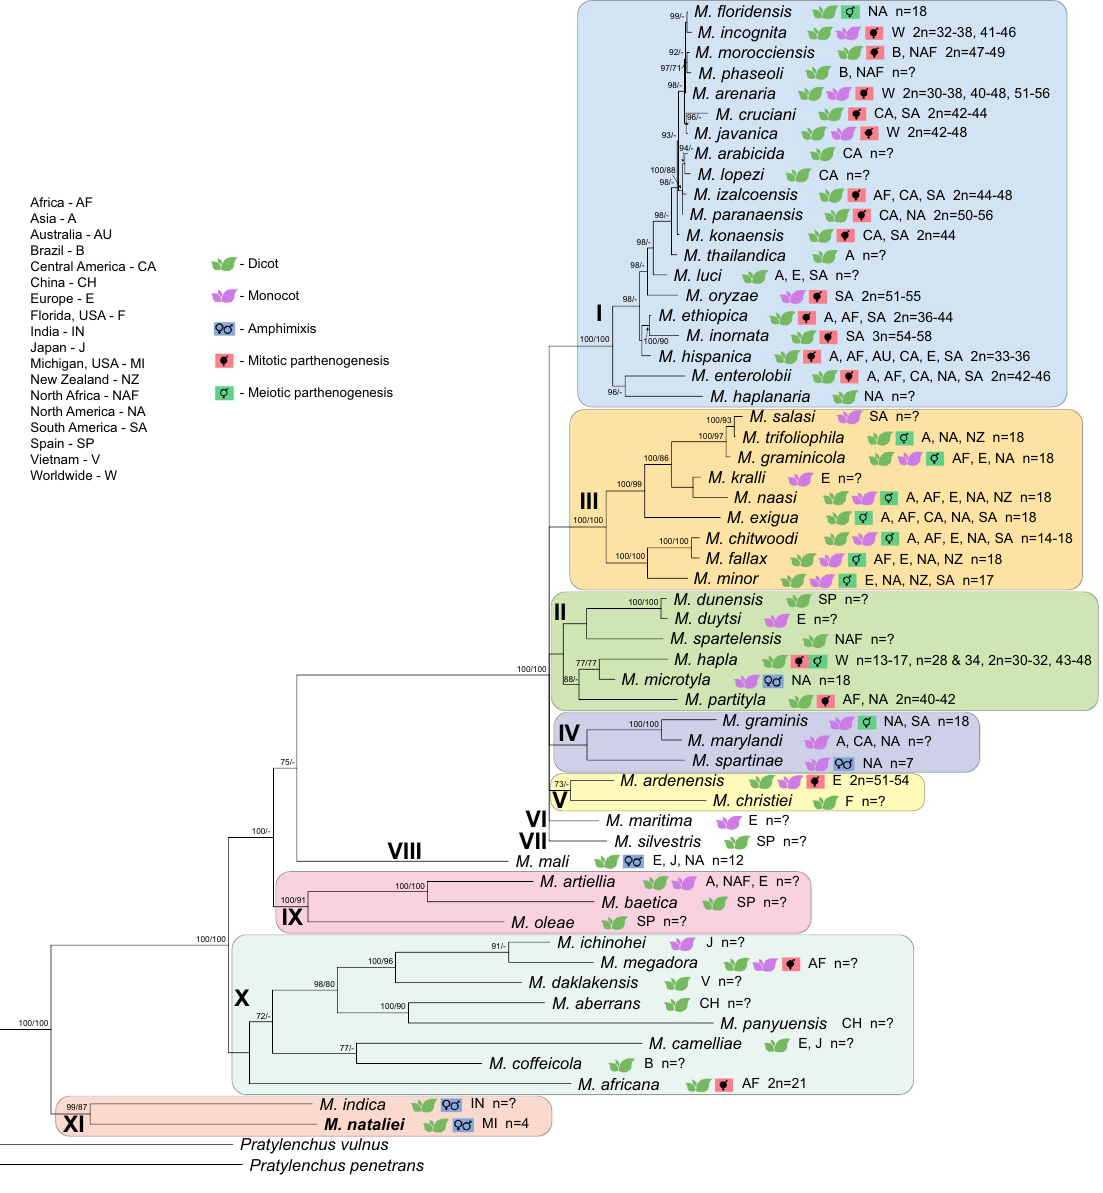
Figure 4. Bayesian 50% majority rule consensus tree as inferred from 18S rRNA, ITS1 rRNA, D2-D3 expansion segments of 28S rRNA, COI gene and COII -16S rRNA sequence alignment under the GTR + I + G model. Branch support of over 70% is given for appropriate clades and it is indicated as: posterior probabilities value in Bayesian inference analysis/bootstrap value from maximum-likelihood analysis. (n = ? – chromosome number information